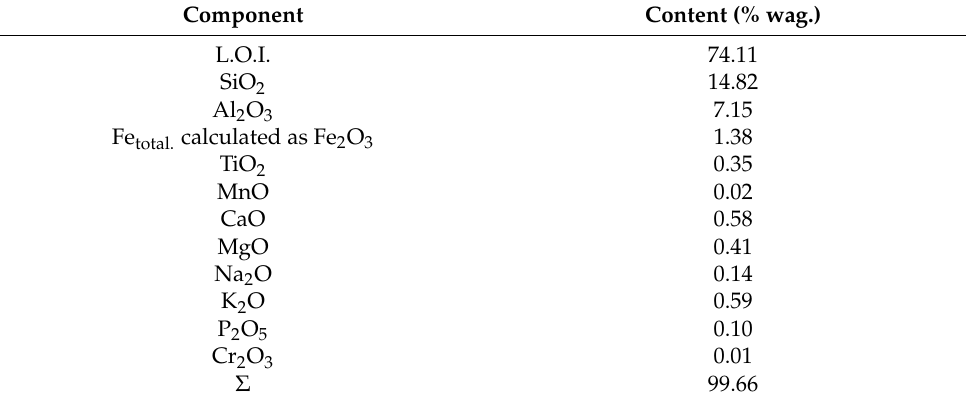
Table 5. Chemical composition of the tested coal (maximum values in